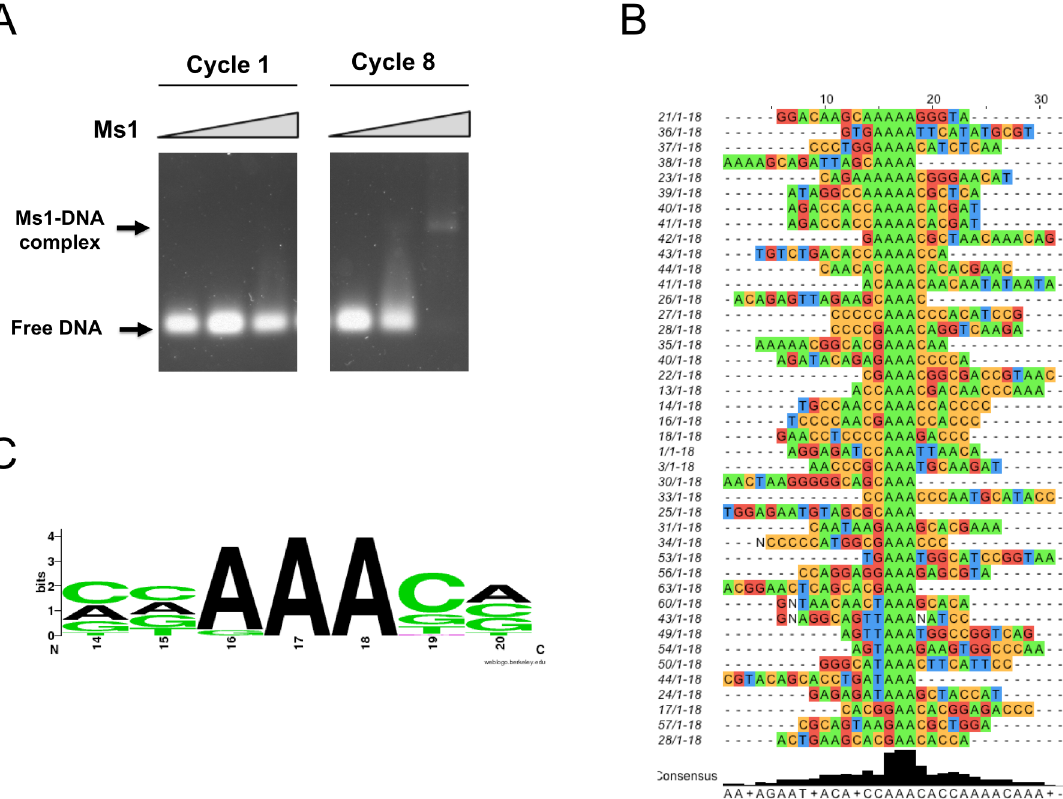
Fig 3. The specificity of DNA binding. A: Gel shift assays with DNA pools from stages 1 (first) and 8 (last) of the SELEX procedure with Ms1 270 – 375. Positions of free and bound DNA are indicated. B: Sequencing results from the final SELEX pool after stage 8. Only random region shown, constant region is omitted. C: Web logo [40] plot of the consensus DNA recognition motif of